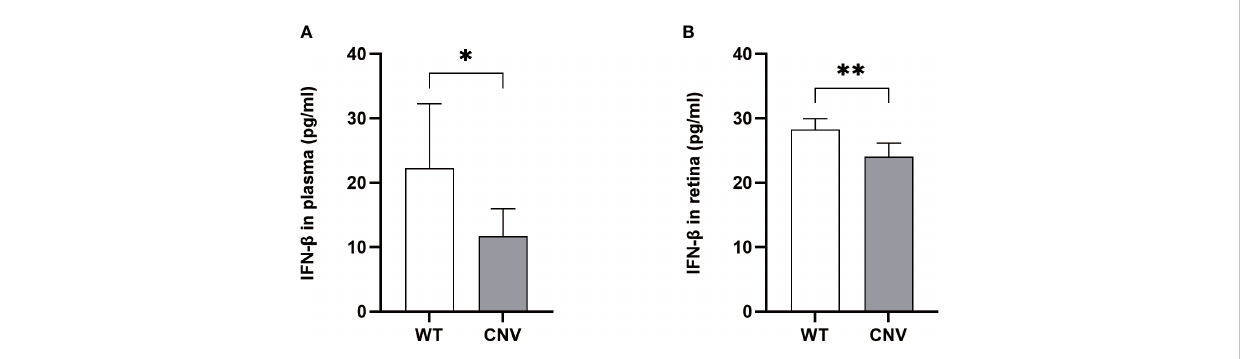
FIGURE 5 Level of IFN- b in the CNV mice. The levels of IFN- b were signi fi cantly lower in the plasma (A) and retina (B) of CNV mice compared with the WT cohort. n = 6; mean ± SD; Student ’ s t -test; * p < 0.05, ** p < 0.01. CNV, choroidal